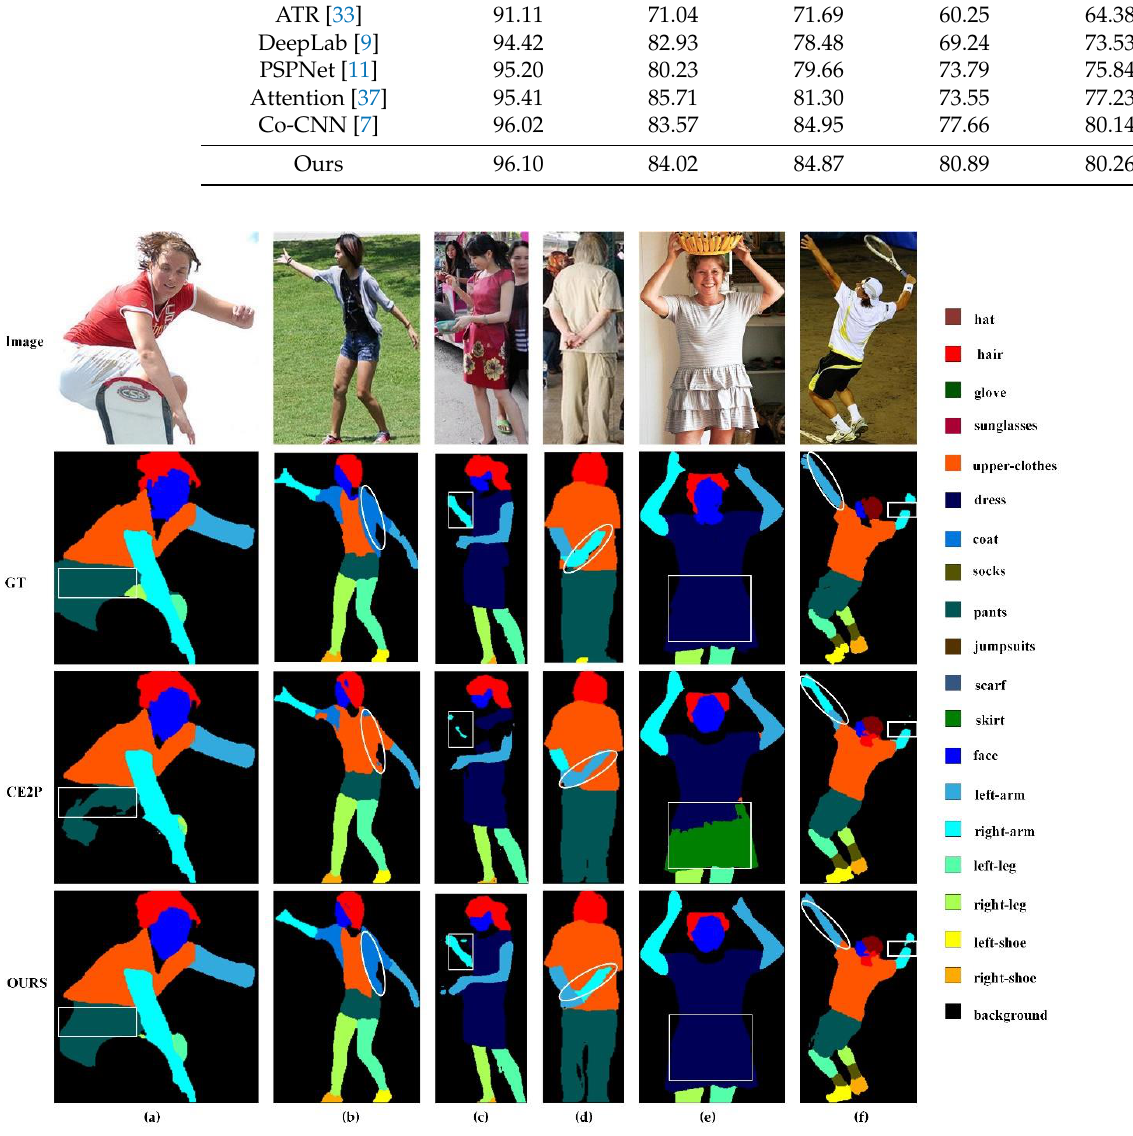
Figure 7. Visualization of different methods on the LIP validation dataset. ( a ) Comparison with CE2P method in terms of object occlusion; ( b ) In terms of comparing similar appearance categories, the CE2P method tends to confuse coat with upper-clothes; ( c ) Compared with multi-person in crowded scenes, our method is more accurate; ( d ) In terms of comparing left and right symmetrical body parts, our method can clearly identify left and right arms; ( e ) In the comparison of categories with similar appearance, the CE2P method misclassifies dress as skirt; (f) Left and right arms are similar in appearance and easily misjudged in CE2P